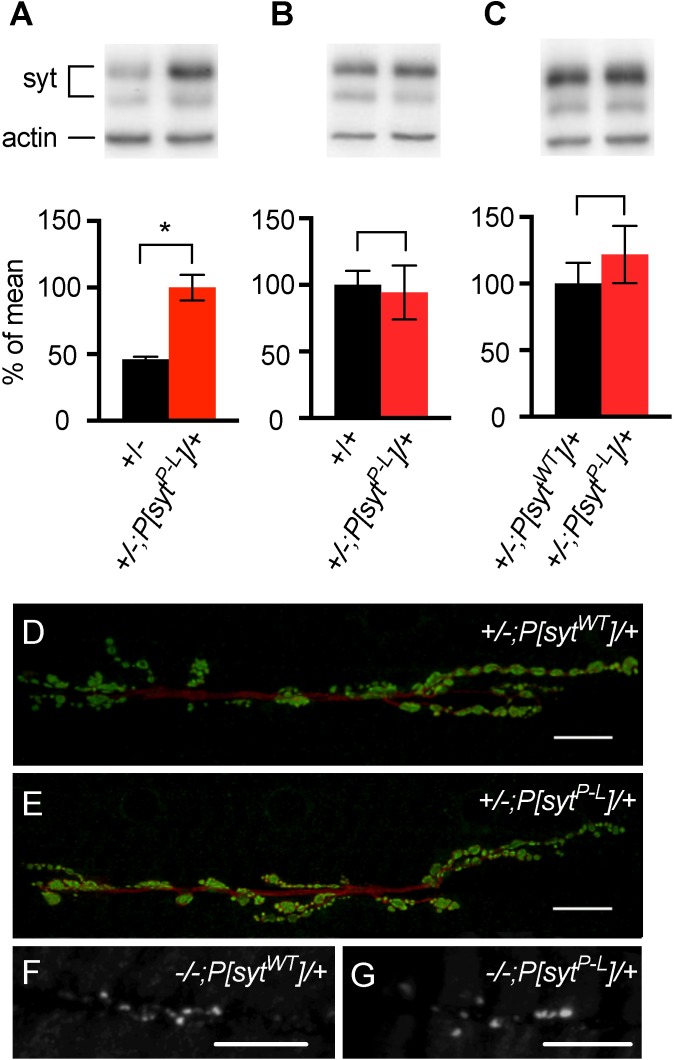
Transgenic synaptotagmin is expressed at appropriate levels and exhibits appropriate localization.(A-C) Representative western blots above and average synaptotagmin expression normalized to actin levels below. Syt heterozygotes expressing one copy of the mutant transgene (+/-;P[sytP-L]/+, n = 6, 5, and 7, respectively) are compared to syt heterozygotes (+/-, n = 5, A), syt homozygotes (+/+, n = 5, B), and syt heterozygotes expressing one copy of the wild type transgene (+/-; P[sytWT]/+, n = 8, C). The P[sytP-L] heterozygotes had approximately twice as much synaptotagmin expression as syt heterozygotes (p = 0.0008, student t-test), while there was no significant difference in expression between the other lines compared (Fig 2B, p = 0.69 and Fig 2C, p = 0.25). Error bars depict SEM. (D, E) Third instar larvae stained with antibodies against horseradish peroxidase (HRP) as a general axonal stain (red) and synaptotagmin (green). Scale bars represent 10 μm. (F, G) First instar larvae stained with antibodies against synaptotagmin. Scale bars represent 20 μm.